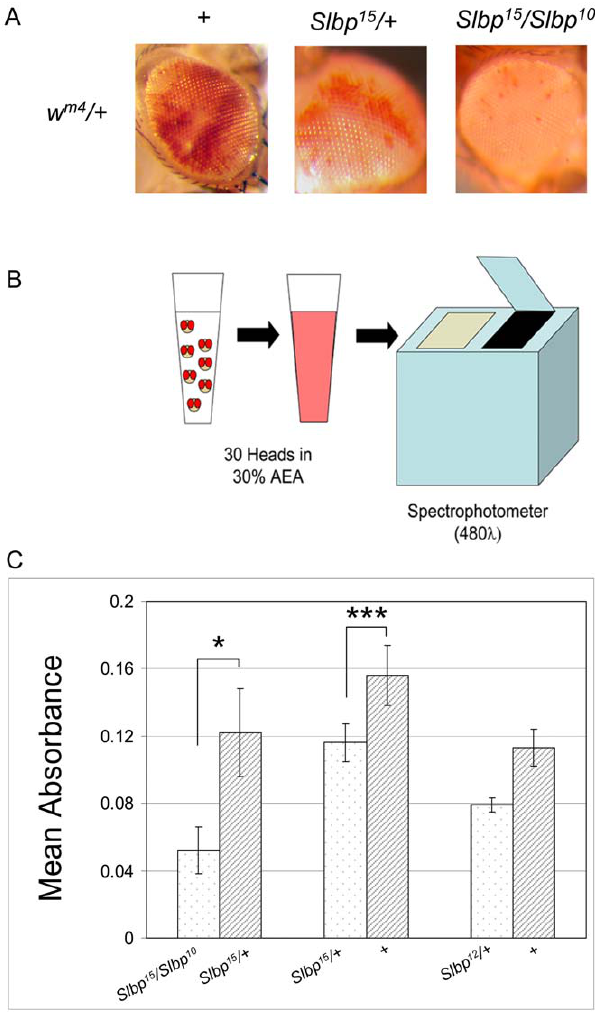
Figure 3. Slbp mutants are modifiers of PEV. Eyes were analyzed for extent of variegation in flies carrying one copy of the w m4 inversion with one of the following genotypes: Slbp 15 /Slbp 10 , Slbp 15 / + , and wt . A) Representative eyes from females of each genotype. B) Quantitative assay for PEV. Eye pigment was quantified by measuring absorbance at 480 l for 30 fly heads per sample. C) Absorbance values of samples from allelic combinations of Slbp mutations. For each genotype, n=10, except when comparing Slbp 15 /Slbp 10 and Slbp 15 / + , for which n=3. Each pair of bars represents a single experiment. P-values are indicated as follows: * p , 0.05, **p , 0.01, ***p , 0.001. Error bars indicate